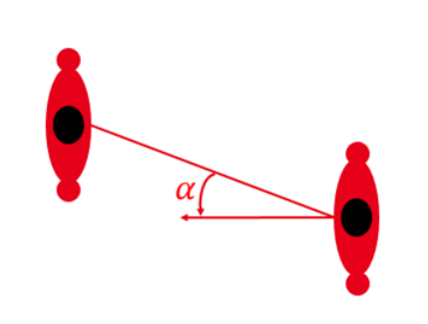
Figure 7. Reciprocal orientation angle.